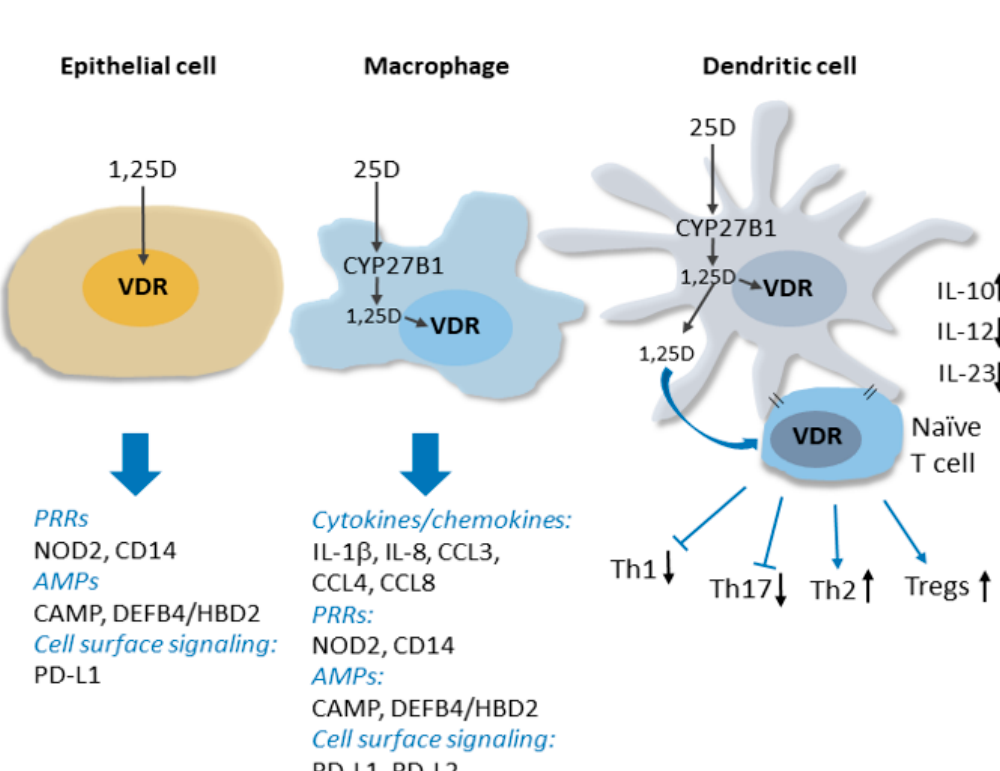
Figure 1. Vitamin D signaling in innate immunity. Intracrine production 1,25D from CYP27B1-catalyzed conversion of circulating 25D in activated macrophages and dendritic cell is shown. The induction of expression by 1,25D signaling through the VDR of genes encoding several types of proteins implicated in innate immune signaling, including cytokines/chemokines, pattern recognition receptors (PRRs) and antimicrobial peptides (AMPs), is indicated. 1,25D signaling within and release from dendritic cells influences dendritic cell maturation and suppresses production of inflammatory Th1 and Th17 cells, favouring Th2 and Tregs. See text for details.